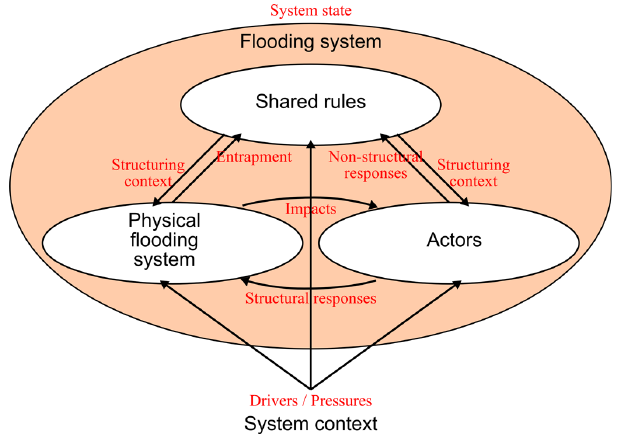
Fig. 2. Simple conceptualisation of the flooding system and its con- text, with components in oval boxes and relations in